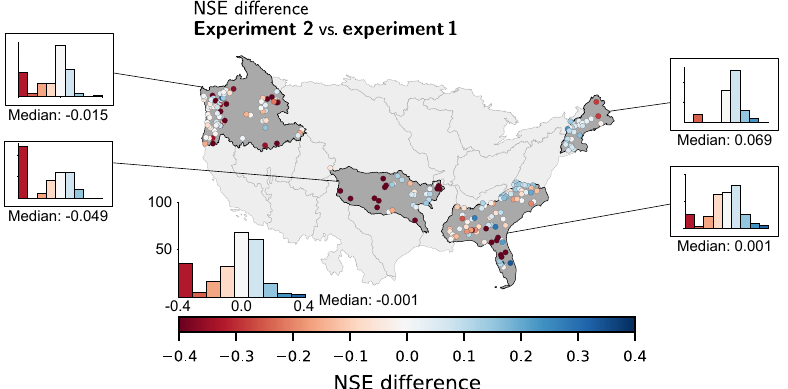
Figure 10. Difference of the regional model compared to the models from Experiment 1 for each basin regarding the NSE of the validation period. Blue colours ( > 0) mean the regional model performed better than the models from Experiment 1, red ( < 0) the other way around.